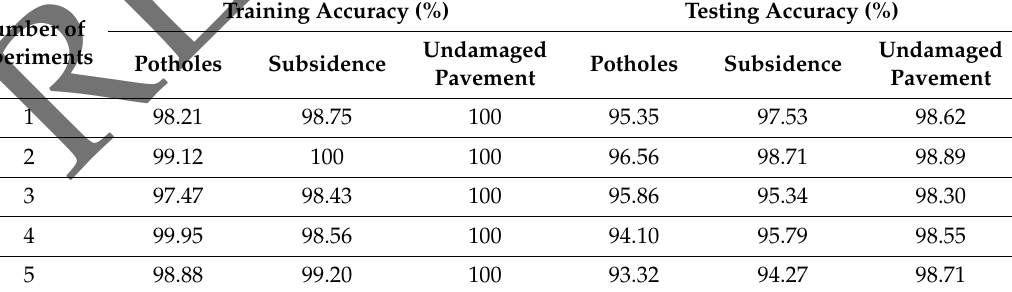
Figure 16. Distribution of the training samples. Table 6. Statistics of classification accuracy.